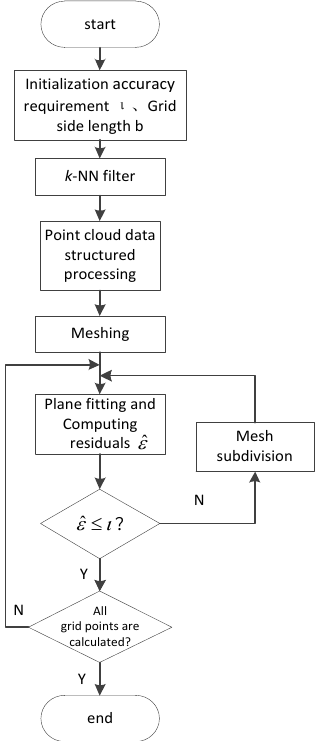
Figure 1. Path point extraction process.